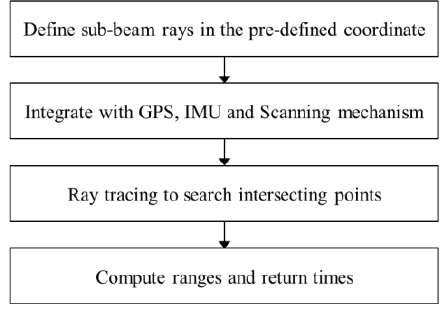
Figure 3. Processes of geometric simulation 2.2.1 Sub-beams : To define rays of sub-beams, we computed the footprint (coverage of laser beam) at a nominal distance by the divergence and the beam width. Then, we divided the coverage with the consistent interval which is computed considering the number of sub-beams. The ray of each sub-beam can be defined by line-equation passing the detector (0, 0, 0) and the centre of the divided area, as shown in Figure 4 (Kim et al , 2009).